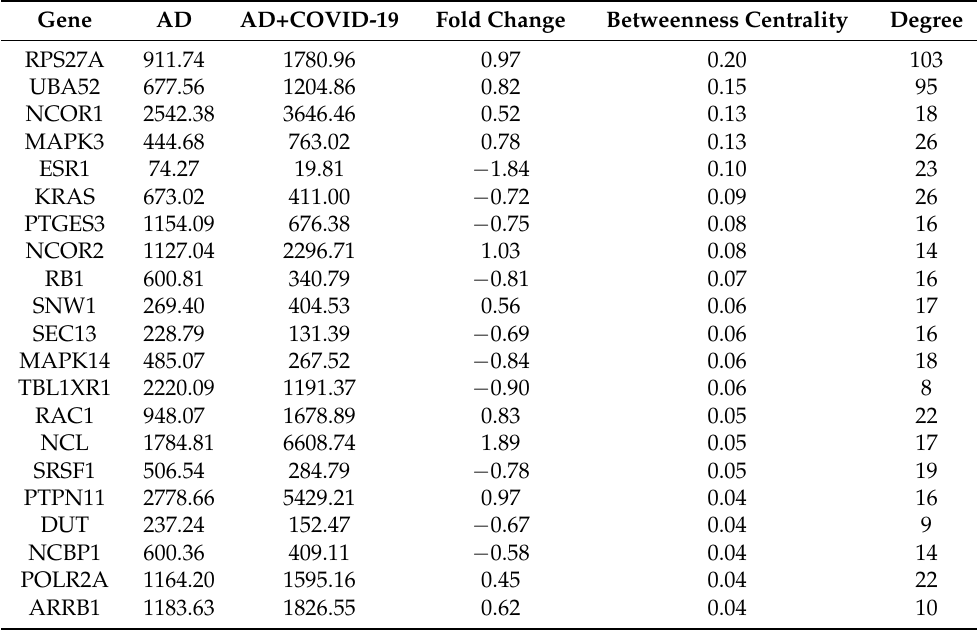
Table 2. DEGs with betweenness centrality outer than 95% after z-score normalization.